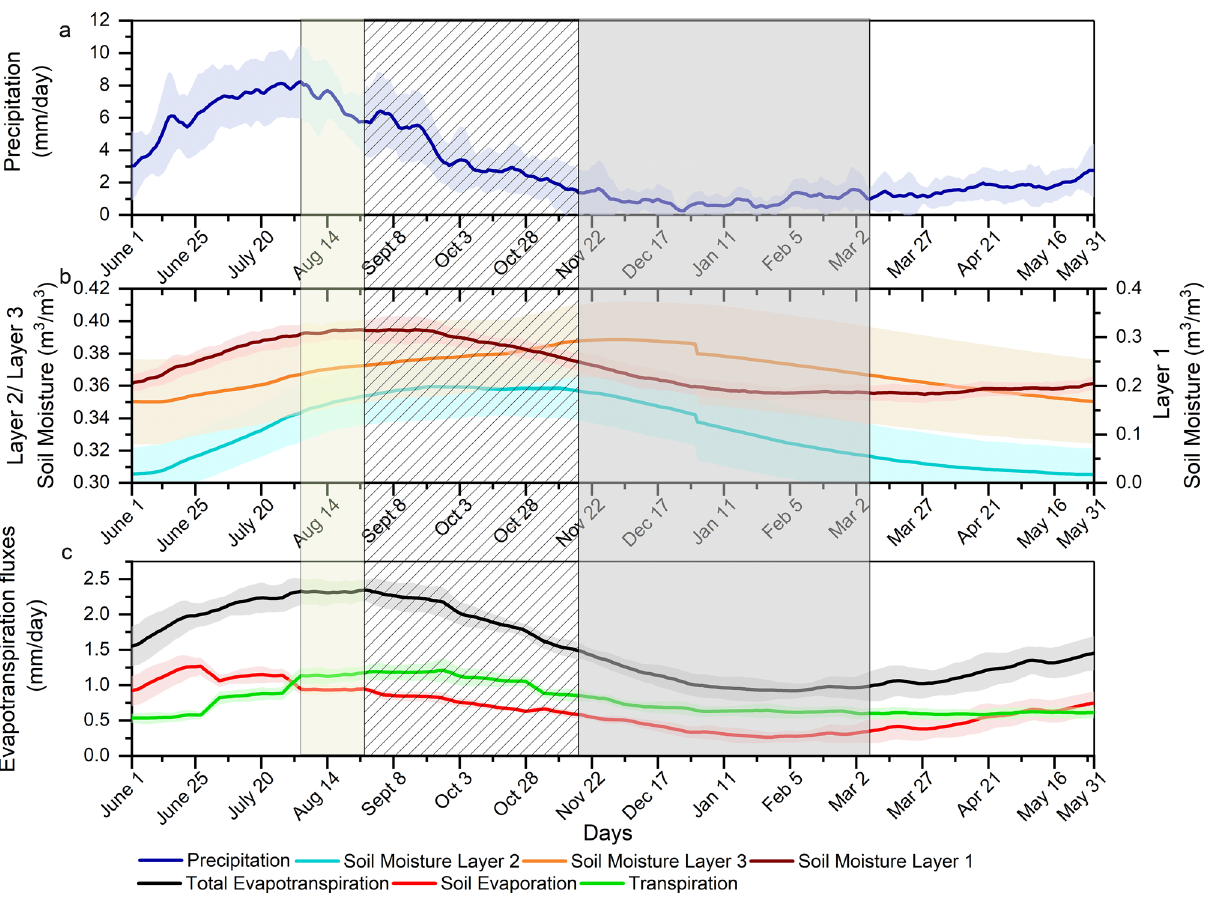
Figure 3. Climatology of ( a ) Observed precipitation ( b ) VIC simulated moisture content in different soil layers, ( c ) VIC simulated total evapotranspiration and its components for the period 2001 to 2015. The shaded yellow, hatched and grey regions correspond to the delayed response period, pre-capacitor period and capacitor period, respectively. The plots are prepared in Origin